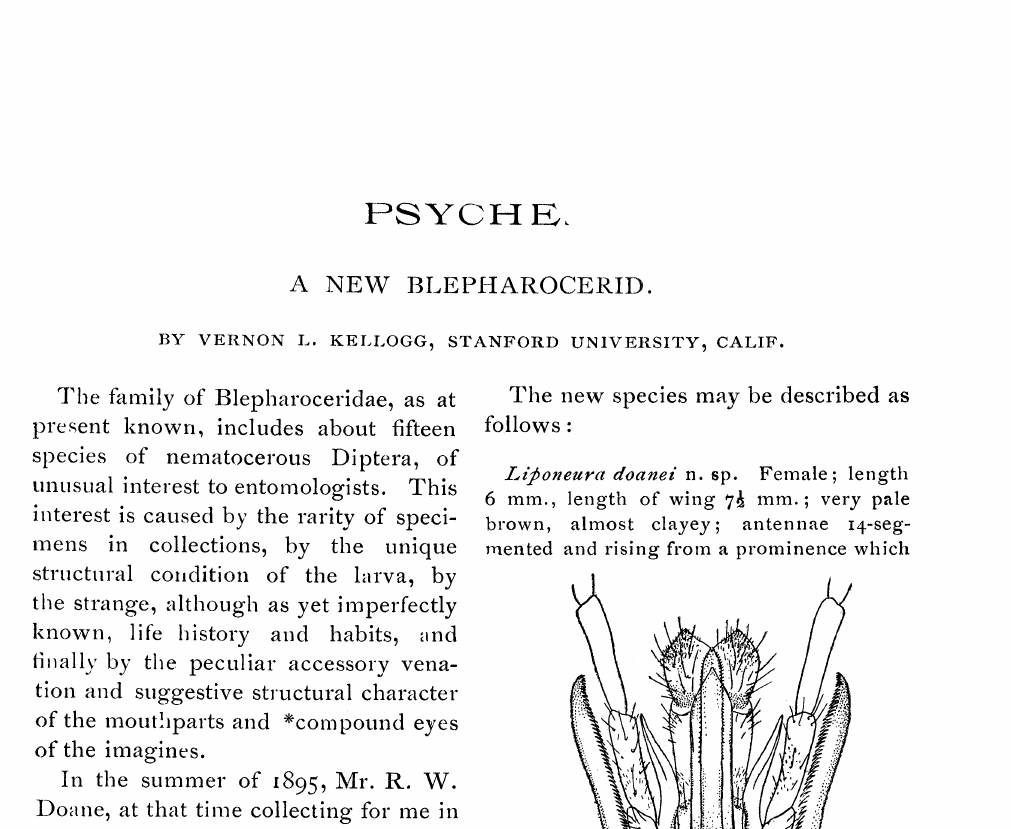
Fig. z. Mouthparts of L@oneura doane[ n.